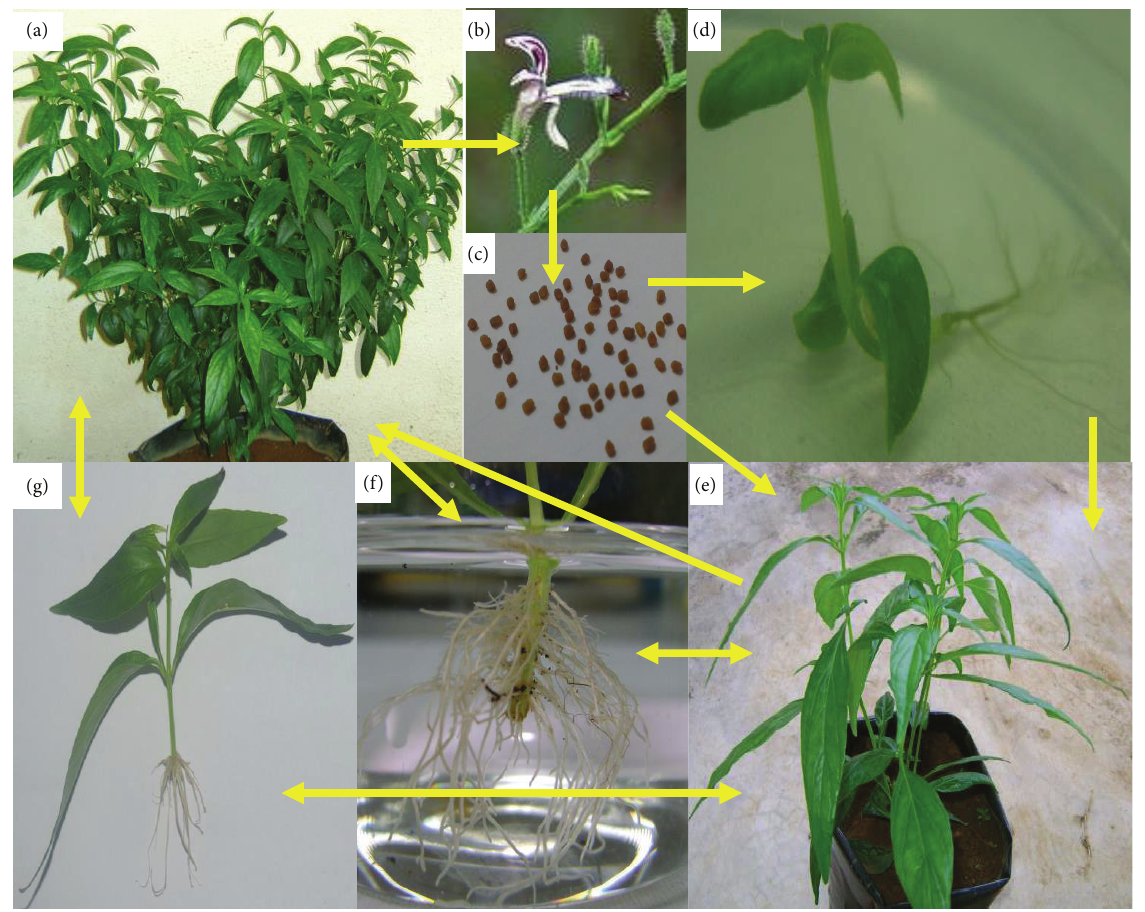
Figure 1: Morphology of Andrographis paniculata . (a) Mature A. paniculata in polybag stage, (b) flowering stage, (c) harvested seeds, (d) in vitro seedling, (e) young A. paniculata in polybag, (f) adventitious roots of A. paniculata , and (g) vegetative seedlings. Single direction of arrow indicates the developmental stages and both directions of arrow denote vegetative propagation of plant (Photographs are taken from M.S. Hossain’s research work, except